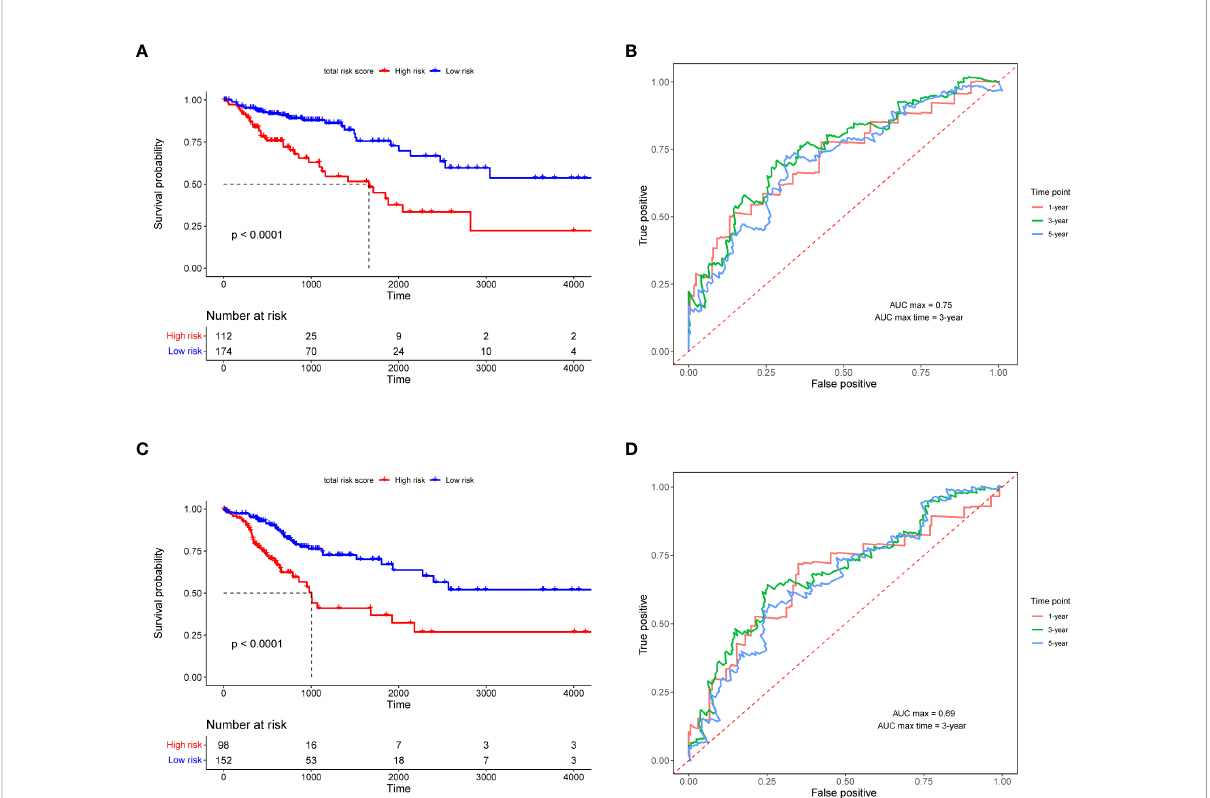
FIGURE 4 Validation of RS signature. The Kaplan – Meier survival curves (A, C) and the ROC curves (B, D) of overall survival and disease-free survival for the RS signature in TCGA training dataset. In the KM survival curve, the horizontal coordinate represents the survival time and the vertical coordinate is the survival probability. In the ROC curve, the false positive rate (1-speci fi city) is the horizontal coordinate and the true positive rate (sensitivity) is the vertical